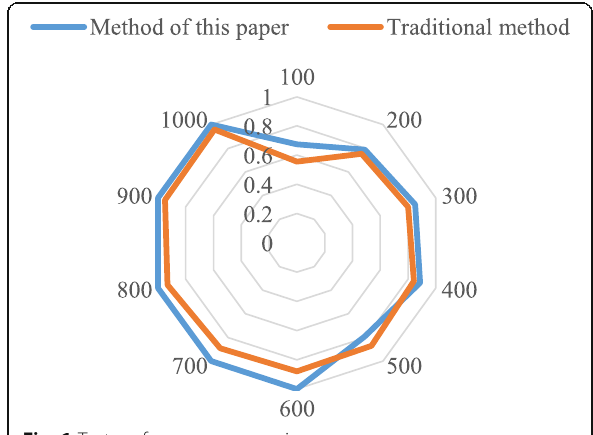
Parallelization of the SCSRC algorithm on the cloud platform